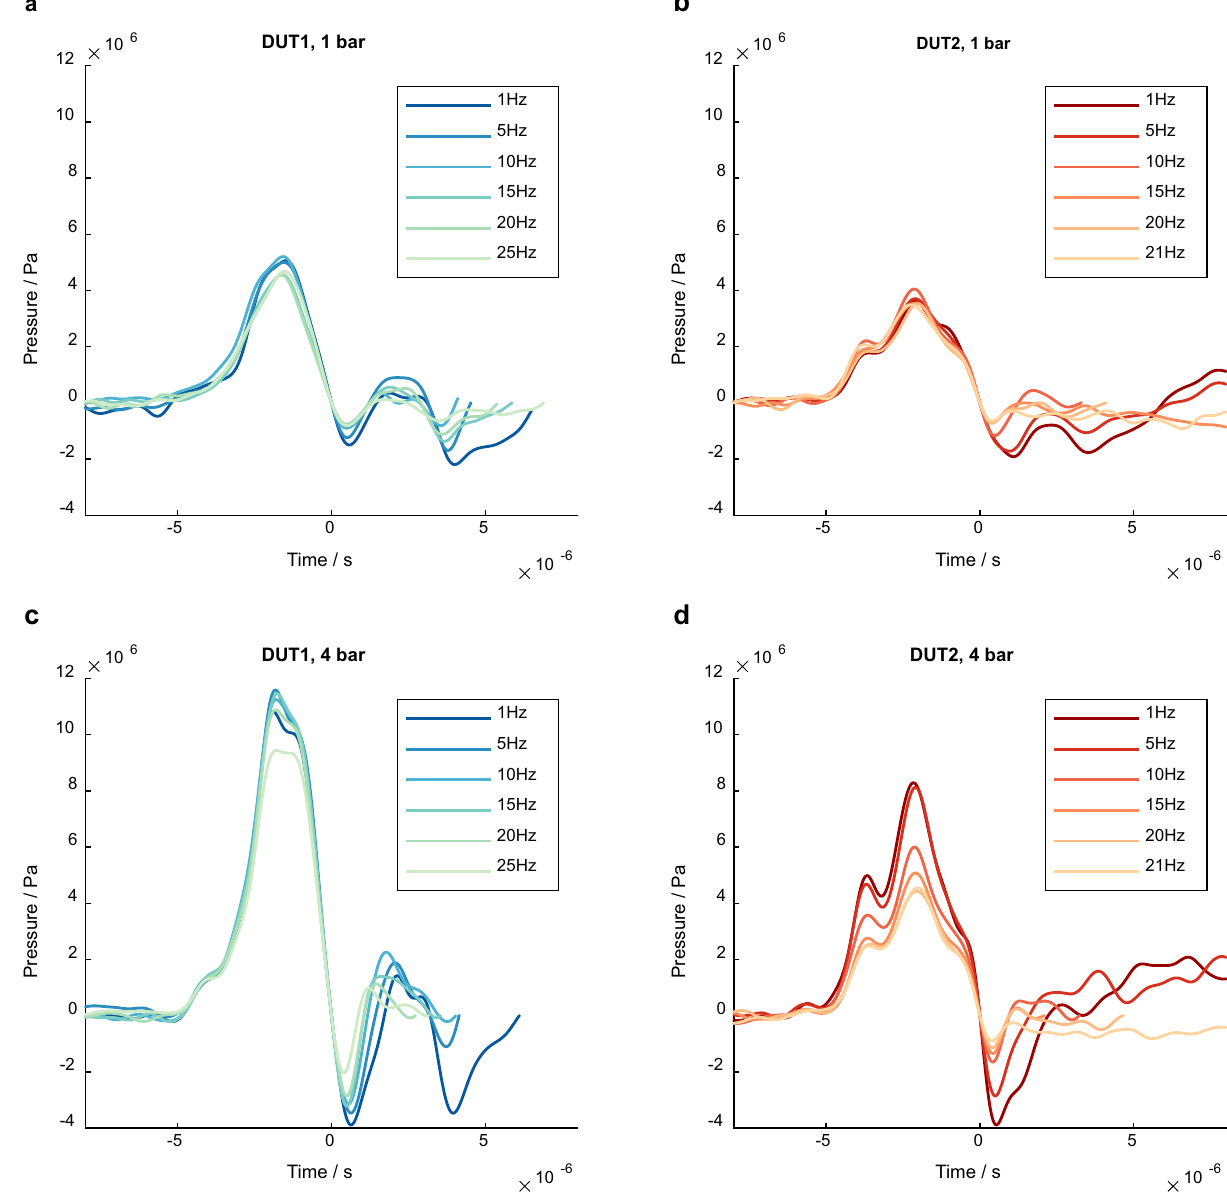
Figure 2. Examples of the filtered mean pressure curves at different pulse repetition rates at 1 bar ( a , b ) and at 4 bar ( c , d